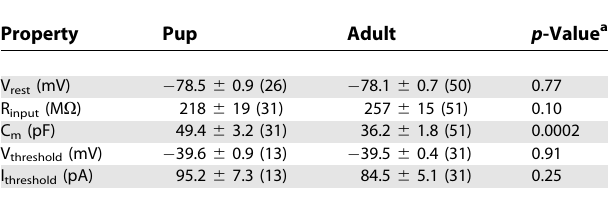
Table 1. Intrinsic Properties of DGCs Born in the Early Postnatal and Adult DG